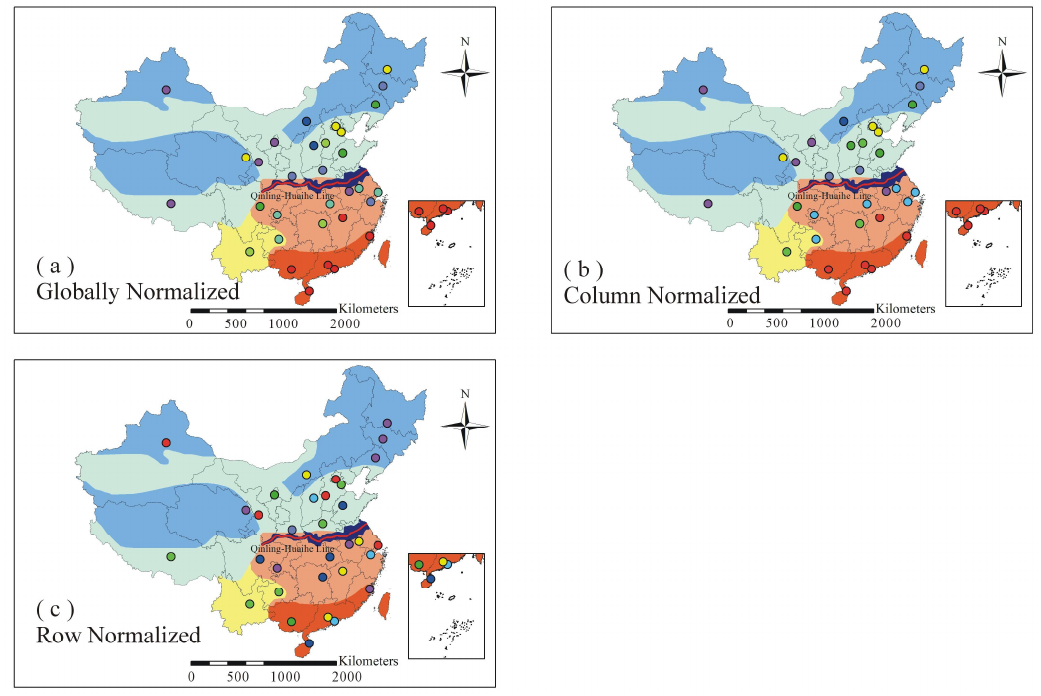
Figure 5. Self-organizing map (SOM) clustering results based on the SUHII calculated using the following normalization methods: ( a ) global; ( b ) column; and ( c ) row.